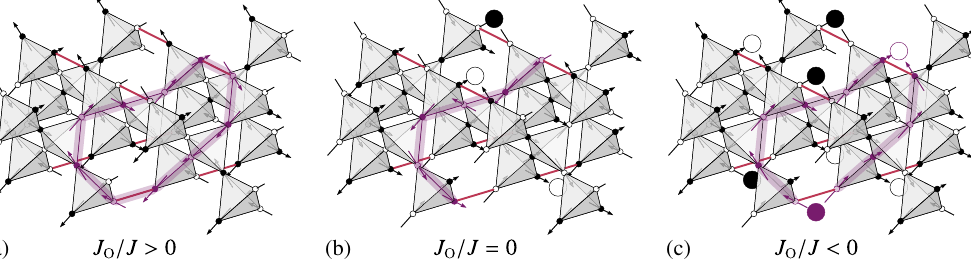
=J ¼ þ 1 , 0, − 1 . (a) When J =J > 0 , the orphan-bond spins are O O 0 , no specific configuration of the orphan-bond spins is O ¼ =J < 0 , the orphan-bond spins are aligned, leading O